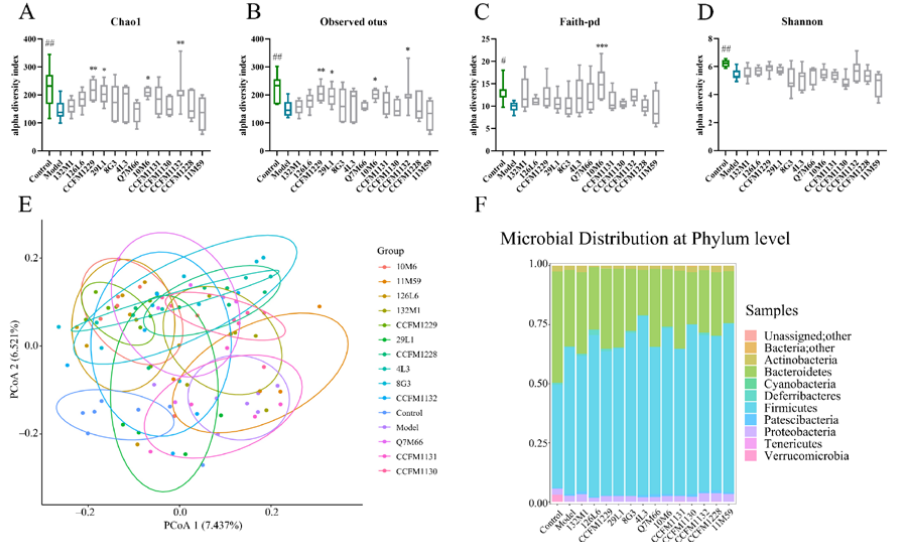
Figure 5. Gut microbiota analysis. ( A – D ) Alpha diversity indicated by Chao 1 index, observed OTUS, Faith-PD and Shannon index. ( E ) PCoA. ( F ) Microbial distribution at the phylum level. # p < 0.05; ## p < 0.01; * p < 0.05; ** p < 0.01; *** p < 0.001 comparing with depression group; n = 7–9.